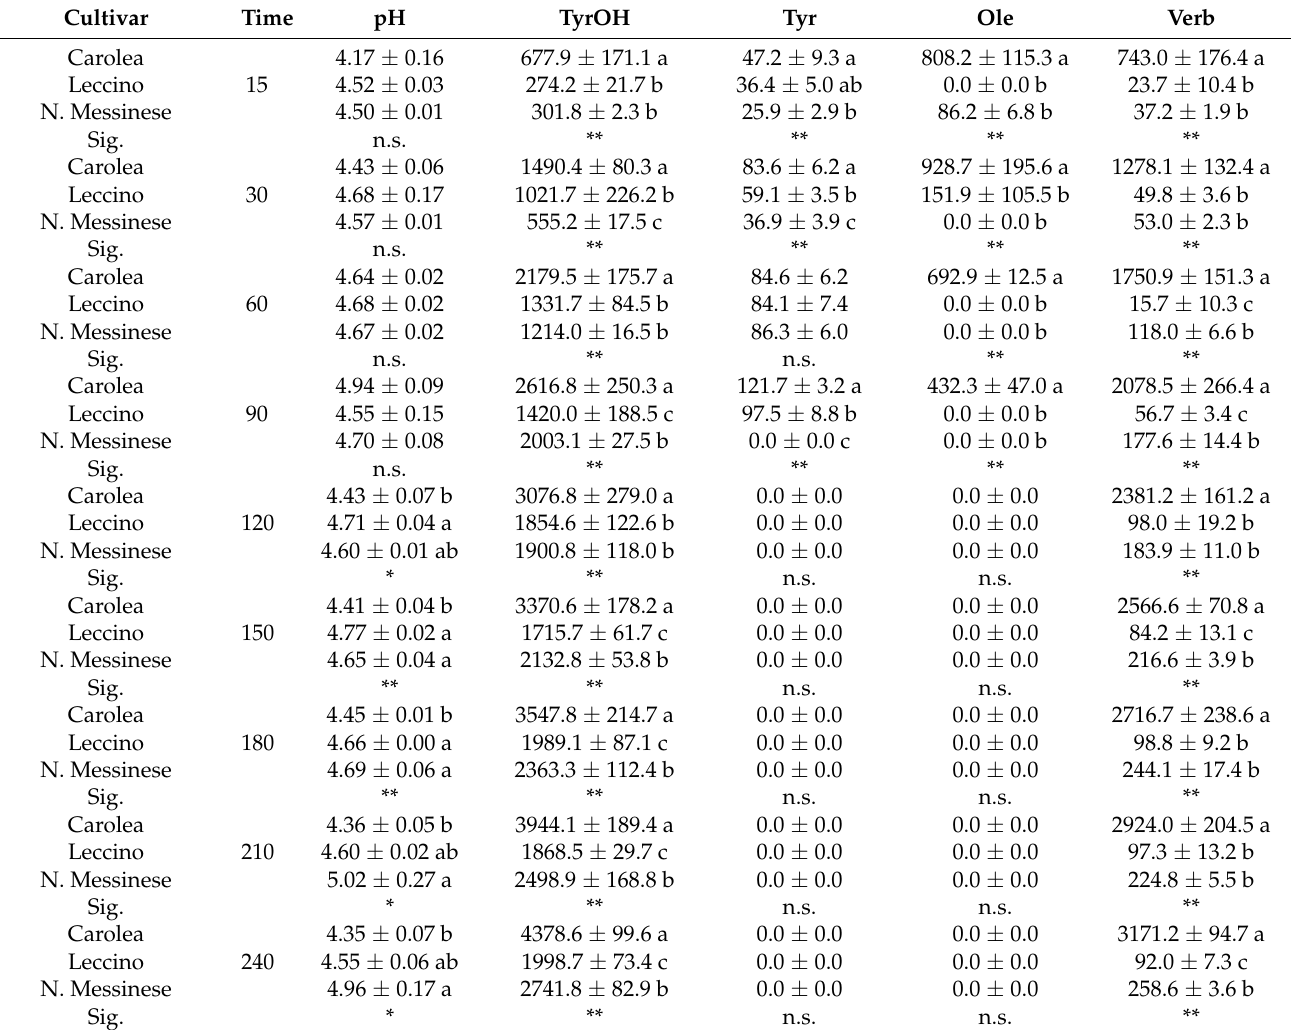
Table 2. Results of pH and single phenolic compounds (mg/L) in the natural fermented (NF) olive